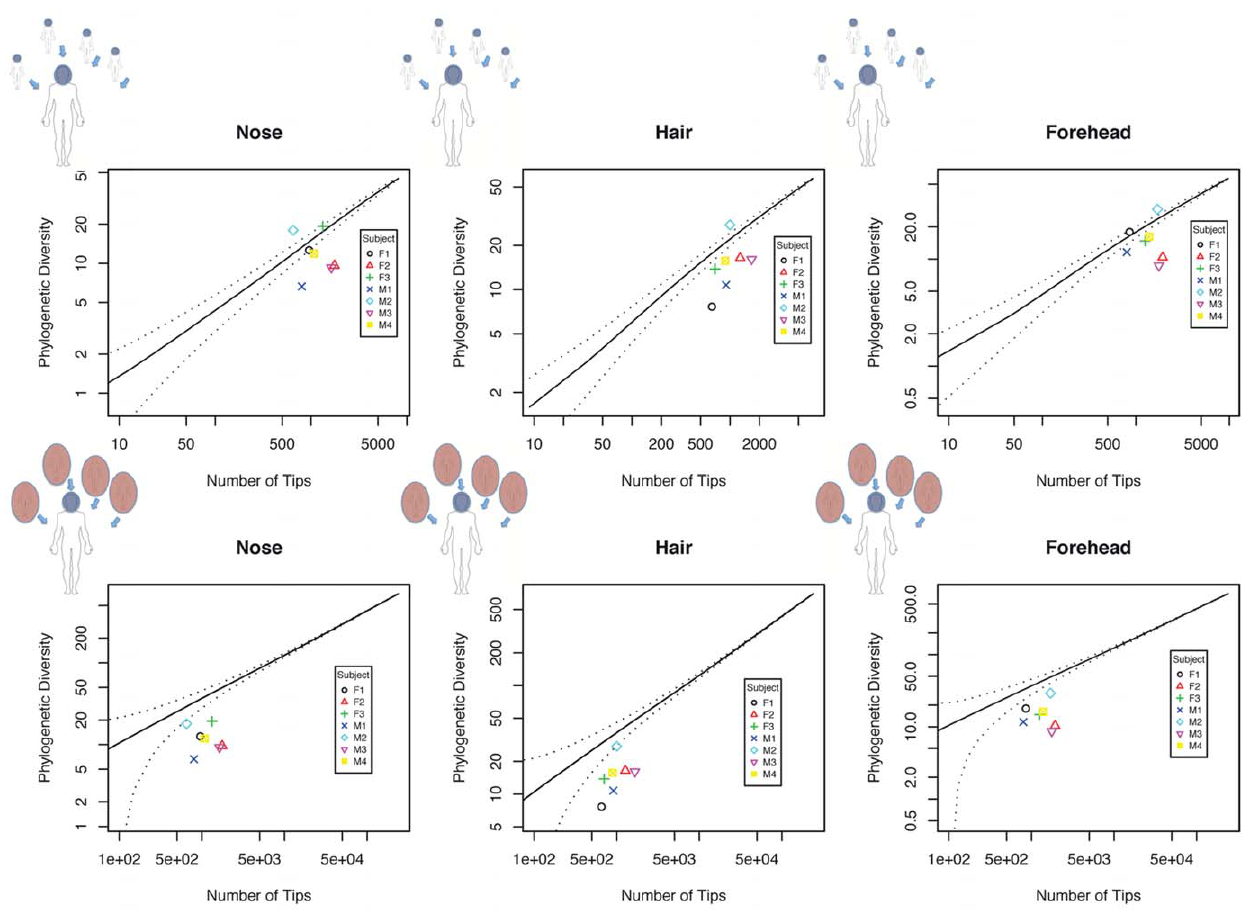
Figure 6. Changing metacommunity scale can change whether samples appear clustered or overdispersed. We show a comparison of actual PD with expected PD under random sampling for three habitats: nose, hair and forehead. Solid lines represent expected PD from random sampling as a function of expected number of tips, dashed lines represent an upper bound on the 95% confidence interval computed using the variance in sampled PD (see Supplementary Information). Points represent actual PD from each of seven human subjects on one sampling day, with subjects labeled by a letter (M or F indicating male or female) and an identifying number. On the top row the reference metacommunity is all reads from that specified habitat, pooled across all seven subjects, and on the bottom row the metacommunity is all sampled reads across all subjects and all habitats. Our central conclusion is that while most samples are consistent with phylogenetic clustering, irrespective of the metacommunity, a minority of communities are consistent with overdispersed sampling from the smaller metacommunity, but clustered sampling from the larger.